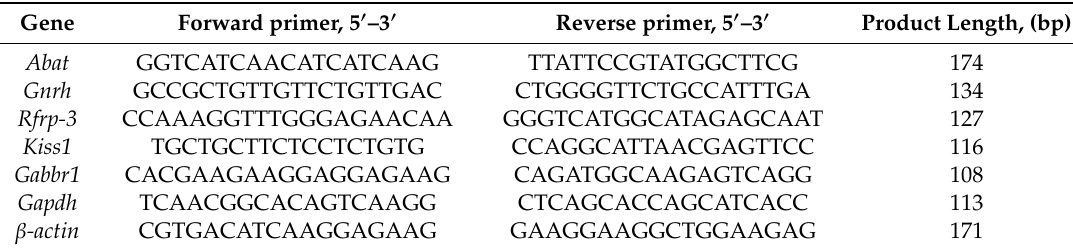
Table 1. Primers Used for